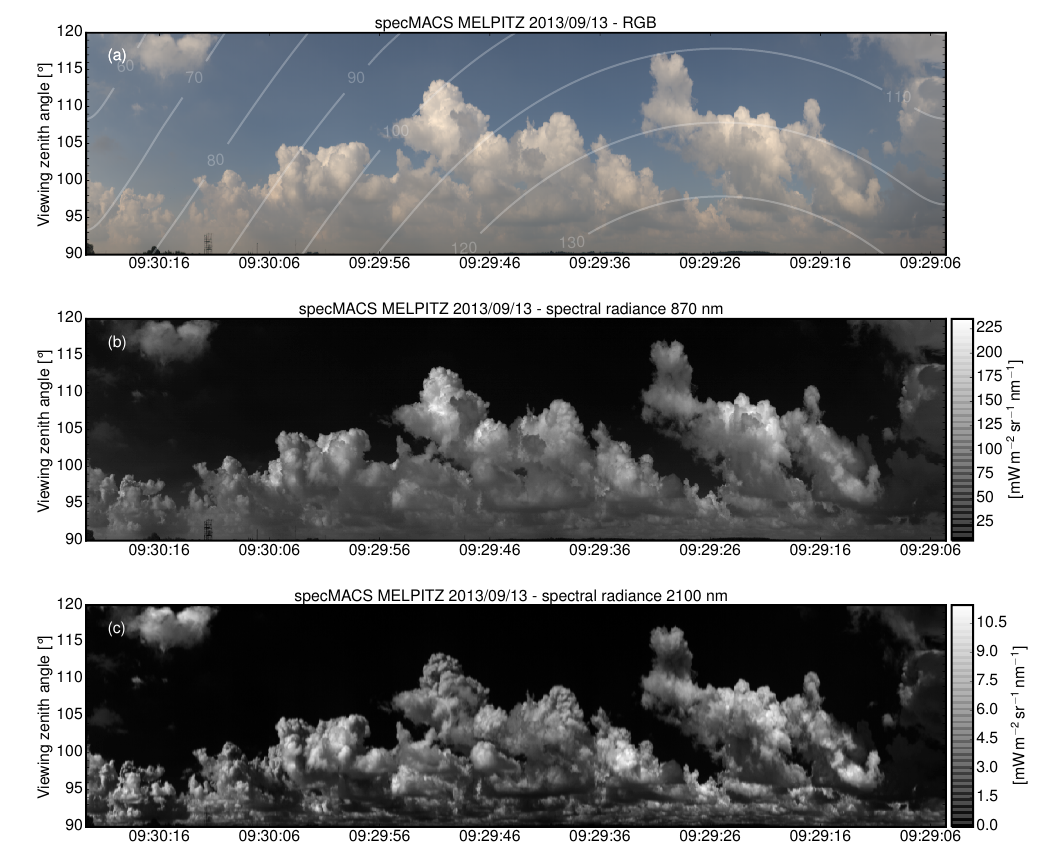
Figure 19. Spectral measurements of cloud sides taken with specMACS on a scanning mount during the HOPE campaign in Melpitz. (a) True-color RGB calculated from the hyperspectral image. (b) Spectral radiance image at 870nm. (c) Spectral radiance image at 2100nm. Due to higher absorption and shorter photon path lengths, clouds appear more structured at 2100nm. The slightly lower radiance from cloud tops at 2100nm could be an indication for larger cloud droplets.